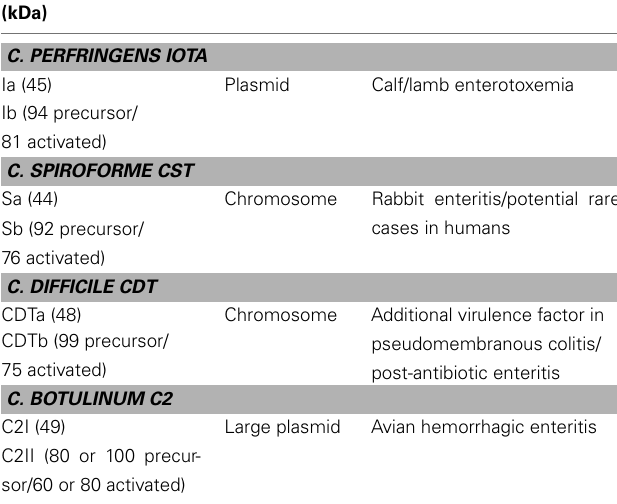
Table 1 | Clostridial binary